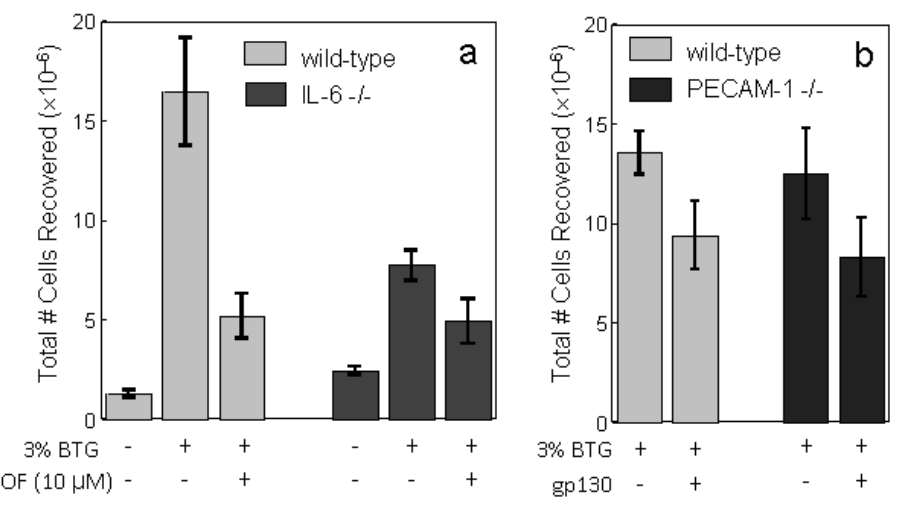
FIGURE 5. The importance of IL-6 in promoting leukocyte recruitment to the inflamed peritoneum. (a,b) Inflammatory cells were removed from the peritoneal cavity of wild-type, IL-6 –/–, or PECAM-1 –/– mice by lavage at 4 h after i.p. injection of BTG. Mice may also have received a single dose of DOF (10 mg/kg) (a) or a single dose of a soluble gp130 (250 ng/mouse) (b). Cell numbers were enumerated by hemocytometer for a minimum of six mice, each performed in triplicate. Data represent the mean ± 95%